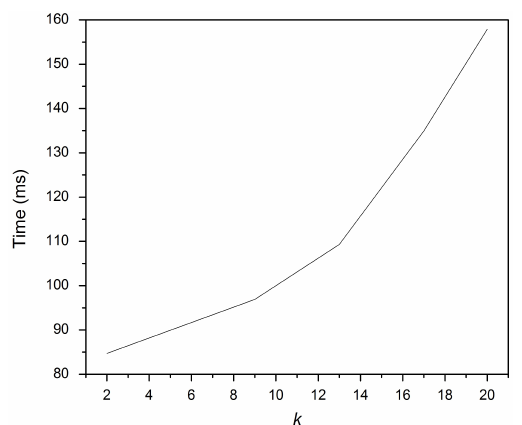
Figure 5. K effect on the time to generate the fingerprint items.